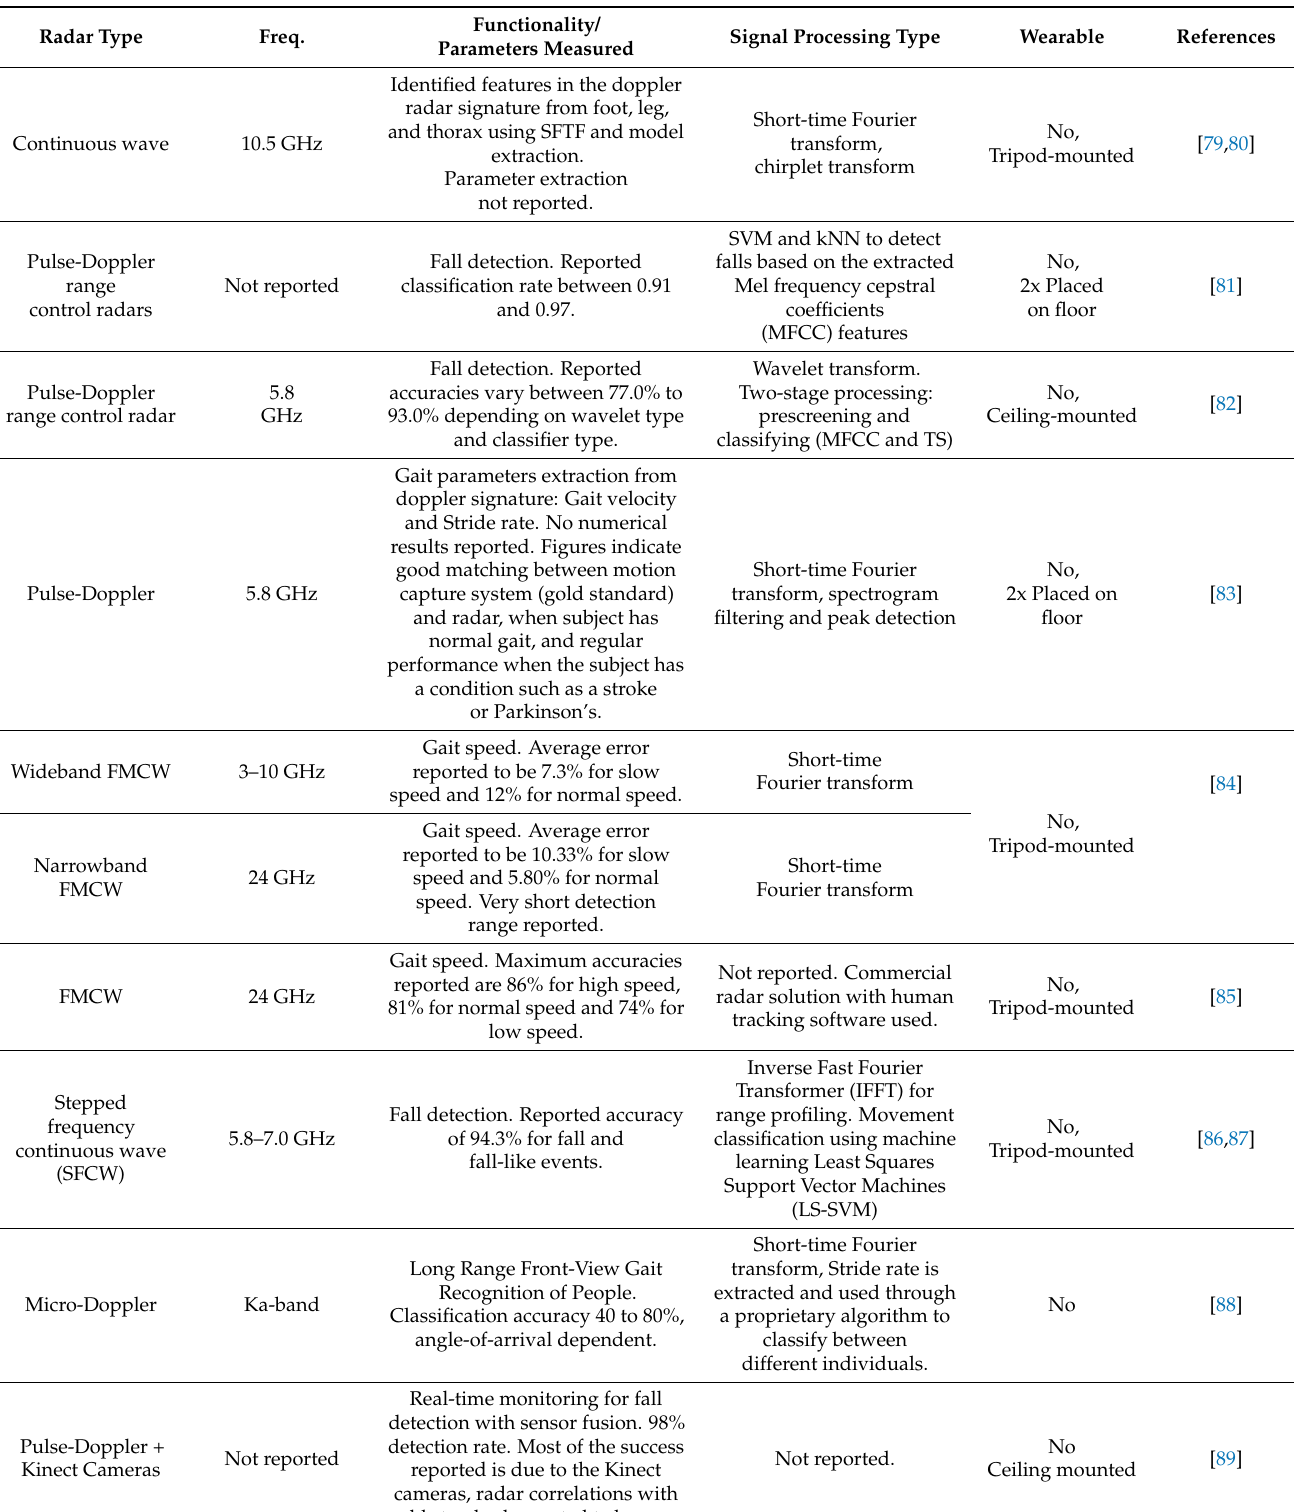
Table 2. Radars in Gait Analysis and Fall